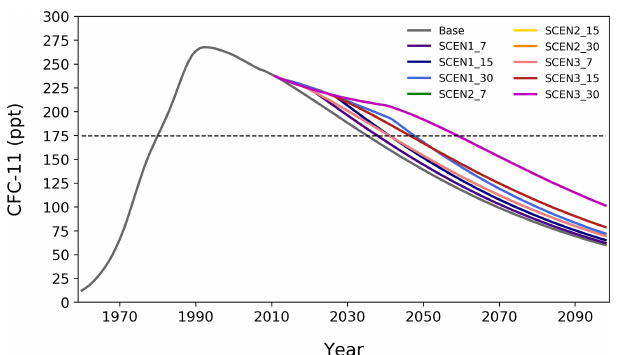
Figure 2. Prescribed global mean, annual mean surface lower boundary mixing ratio of CFC-11 used for the BASE and SCEN simulations. The dashed line represents the 1980 CFC-11 surface mixing ratio in the BASE simulation. Note that the SCEN2 and SCEN3 simulations have the same CFC-11 lower boundary con- ditions.